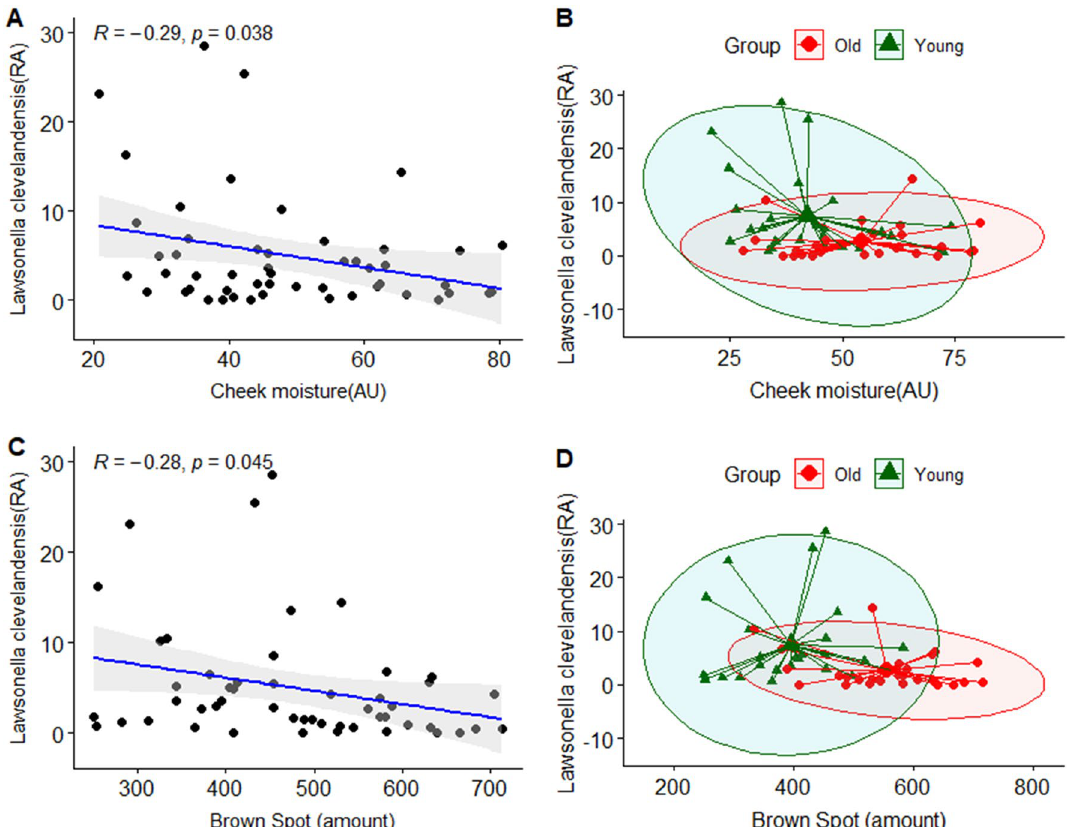
Figure 9. Correlation analysis between the relative abundance (%) of Lawsonella clevelandensis and clinical skin parameters. ( A ) Pearson correlation between the relative abundance (%) of Lawsonella clevelandensis and cheek moisture (AU); ( B ) age-related Pearson correlation between the relative abundance (%) of Lawsonella clevelandensis and cheek moisture (AU); ( C ) Pearson correlation between the relative abundance (%) of Lawsonella clevelandensis and brown spots (amount); ( D ) age-related Pearson correlation between the relative abundance (%) of Lawsonella clevelandensis and brown spots (amount). The green color indicates the younger group, and the red color indicates the older group.